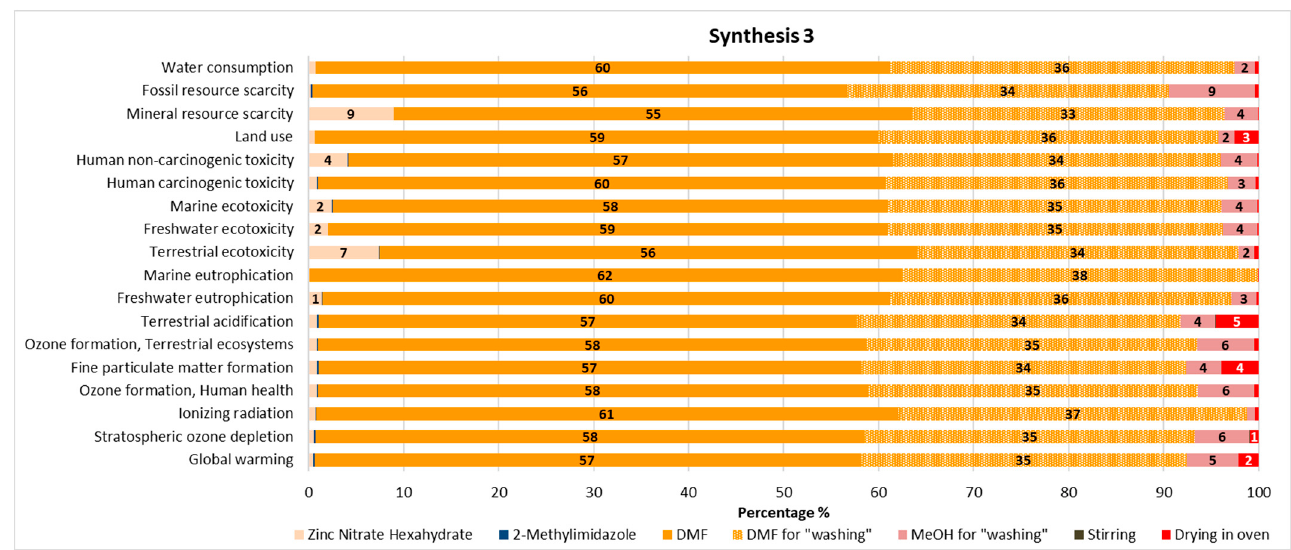
Figure 5. Life Cycle Assessment of the 2nd synthetic approach of ZIF-8. Method: ReCiPe 2016, midpoint (H) V.1.01.